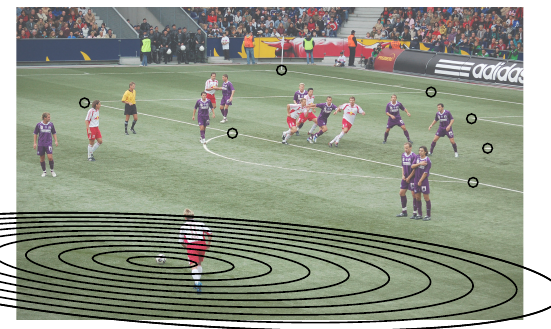
Figure 8. Pose estimation using the marked image points. The camera is mounted on a quadcopter